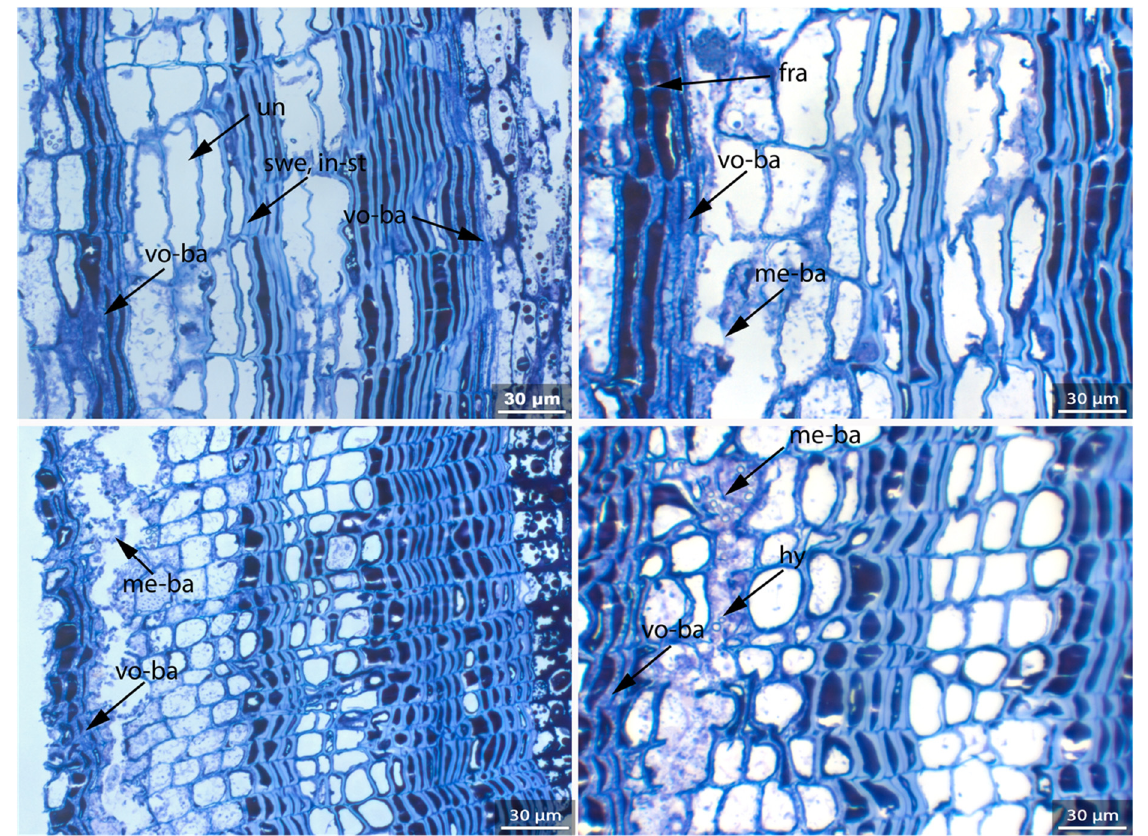
Figure 25. Sample 12. Top left and right: LM of cross-section. Bottom left and right: LM of radial thin section. Bacteria created voids (vo-ba) in secondary cell wall and, in advanced stage, metabolised all cell wall layers and phenolic lumen content of thick-walled cells (me-ba). Cloudy purple material was produced that accumulated in the lumen of thin-walled cells. Decay is strongest on sample surface, on left outer cell bands, indicating that bacteria penetrated from there. Few hyphae are found in the sample (hy). Entire sample shows increased staining (in-st), swollen cell walls (swe) and unfolded thin-walled cells (un). Radial fractures running across phenolic content and cell walls are present (fra).